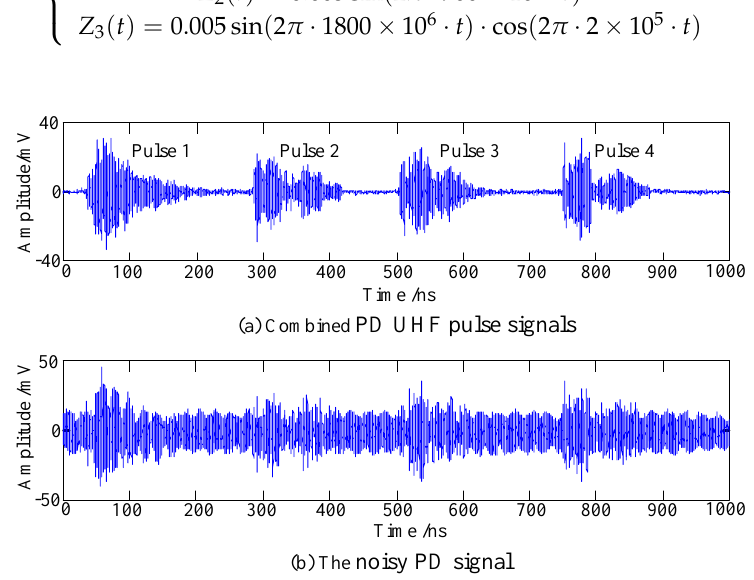
Figure 6. Partial discharge (PD) UHF signals of the simulation tests.